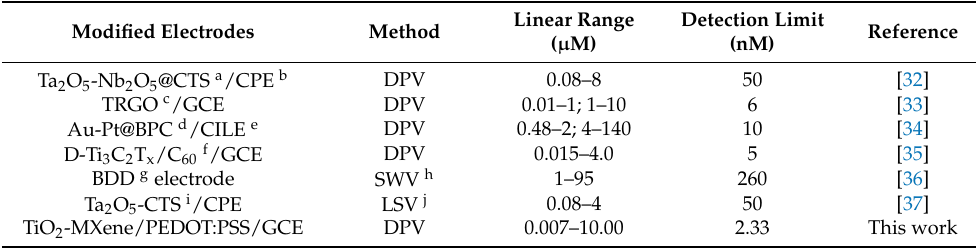
Table 1. Analytical comparison of other previously reported electrochemical sensors for baicalein determination.